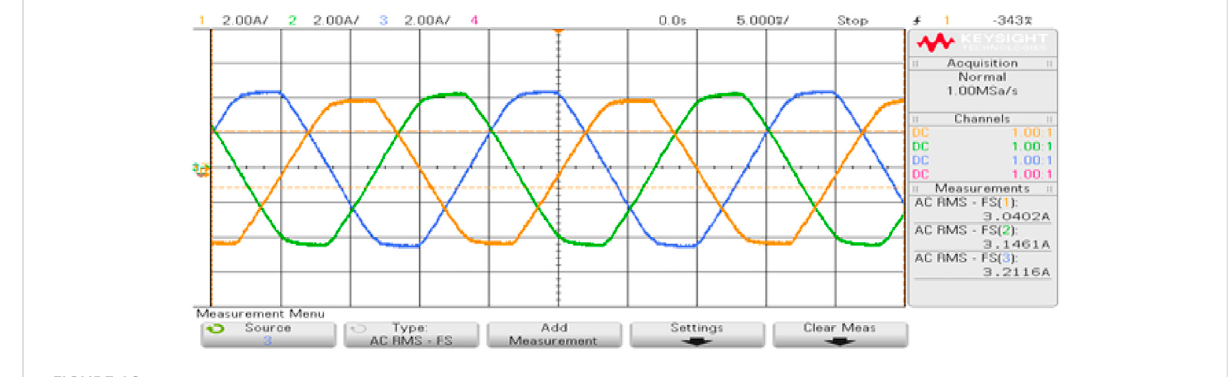
FIGURE 16 Three-phase current.